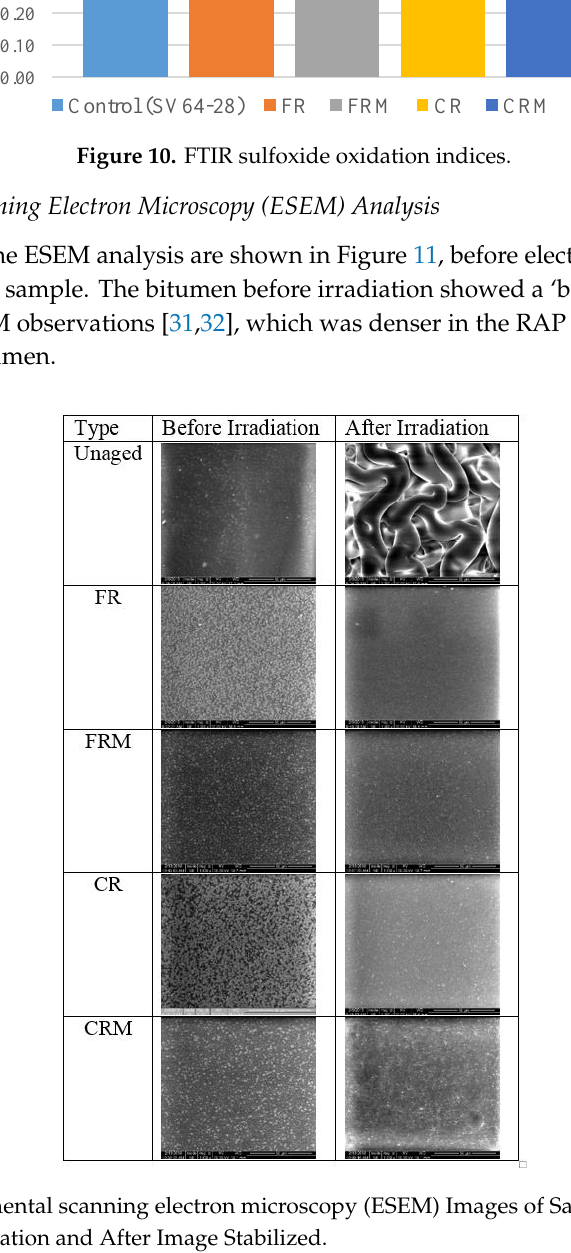
Figure 10. FTIR sulfoxide oxidation indices.